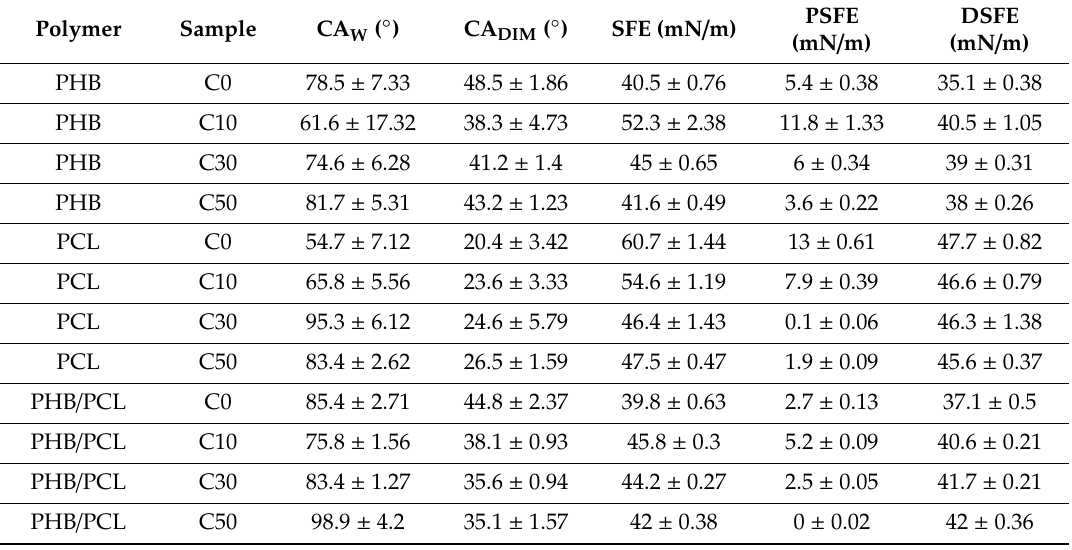
Table 1. Measurements of contact angles and surface energy parameters of polymer films prepared with camphor added at di ff erent